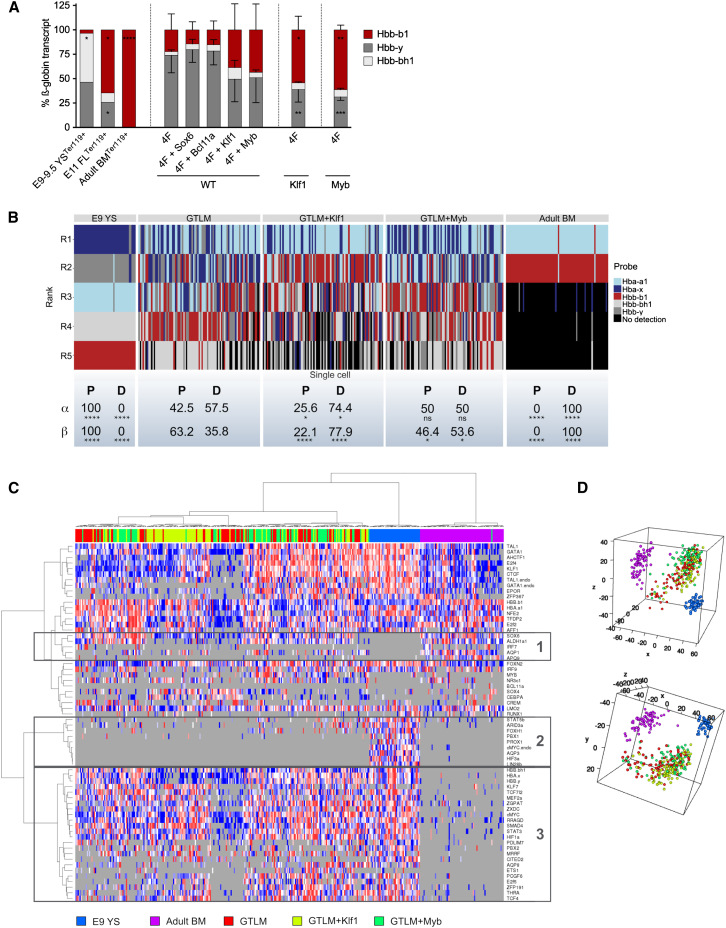
Klf1 and Myb Enhance Adult Hemoglobin Expression in Single iEPs(A) Percentage of embryonic (Hbb-bh1 and Hbb-y) and adult (Hbb-b1) globin transcripts under different test conditions on day 8, determined by qPCR. WT samples denote wild-type TTFs transduced simultaneously with GTLM factors (4F) plus an additional factor. Klf1 and Myb samples denote TTFs with constitutive expression of Klf1 and Myb, respectively, transduced with GTLM factors. Bulk WT GTLM-transduced TTF, Ter119+ cells from E9-9.5 yolk sacs, Ter119+ cells from E11 fetal livers, and Ter119+ cells from adult bone marrow were used as controls. Data are presented as mean ± SD (n = 3–7 for iEP samples, n = 1 for bona fide cells). ∗p ≤ 0.05; ∗∗p ≤ 0.01; ∗∗∗p ≤ 0.001; ∗∗∗∗p ≤ 0.0001.(B) Map depicting expression of globin genes in single sorted YFP+ Ter119+ E9 yolk sac cells, adult bone marrow cells, day 8 GTLM-iEPs, day 8 GTLM+Klf1-iEPs, and day 8 GTLM+Myb− iEPs. Globin genes are ranked by their iCt values (iCt = 50 − Ct) in each single cell from highest (R1) to lowest (R5) (Figure S4B). Percentages of single cells in each group displaying a “primitive” (P) or definitive (D) globin expression pattern are shown below. P if iCtHba-a1 < iCtHba-x for the α locus or iCtHbb-b1 < iCtHbb-y for the β locus; D if iCtHba-a1 > iCtHba-x for the α locus or iCtHbb-b1 > iCtHbb-y for the β locus. ∗p ≤ 0.05; ∗∗∗∗p ≤ 0.0001.(C) Heatmap depicting the expression of 64 genes selected for single-cell qRT-PCR in sorted YFP+ Ter119+ E9 yolk sac cells (blue), adult bone marrow (purple), day 8 GTLM-iEPs (red), day 8 GTLM+Klf1-iEPs (yellow), and day 8 GTLM+Myb− iEPs (green).(D) Principal component analysis. Shown are three-dimensional plots of five sample sets shown from two different points of view. Sample color labeling is consistent with Figure 4C.See also Figure S4.